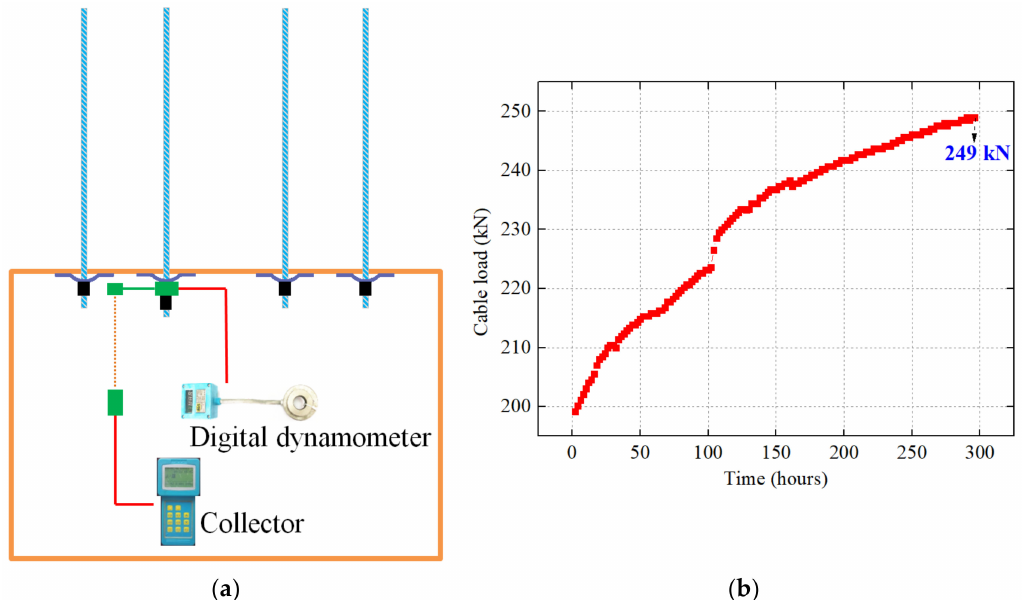
Figure 16. Roof anchor cable working load monitoring: ( a ) monitoring stations and methods (repro- duced from [30]); ( b ) monitoring results.